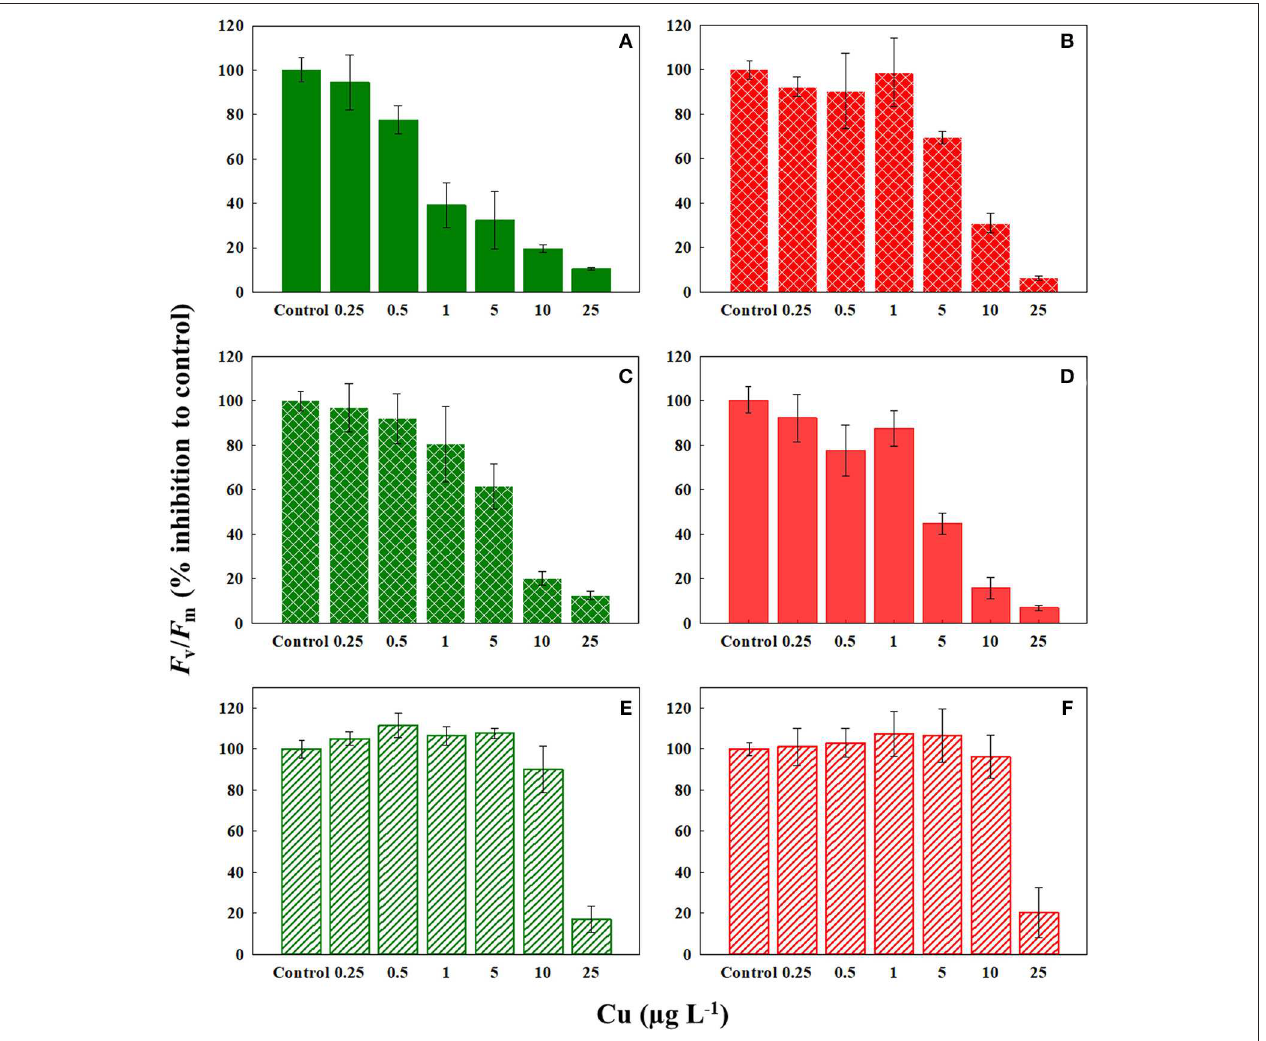
FIGURE 3 | Response of F v / F m of ambient-adapted (green) and warming-adapted (red) strains of Chaetoceros tenuissimus to Cu exposure at various temperatures: (A) ambient-adapted tested at 26 ◦ C, (B) warming-adapted tested at 26 ◦ C, (C) ambient-adapted tested at 30 ◦ C, (D) warming-adapted tested at 30 ◦ C, (E) ambient-adapted tested at 35 ◦ C, and (F) warming-adapted tested at 35 ◦ C. Solid fills: Cu test at selection temperatures, textured fills: Cu test at reciprocal transplants and line fills: Cu test at 35 ◦ C. Data are plotted as treatment means with error bars ±